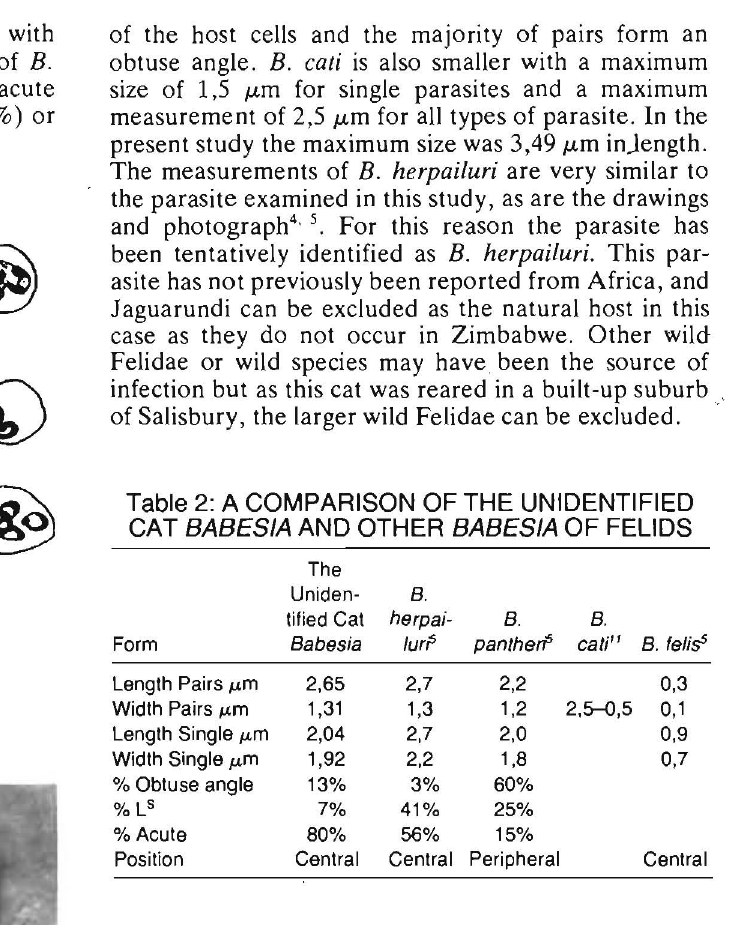
Fig. 1. Drawings of infected red blood cells.